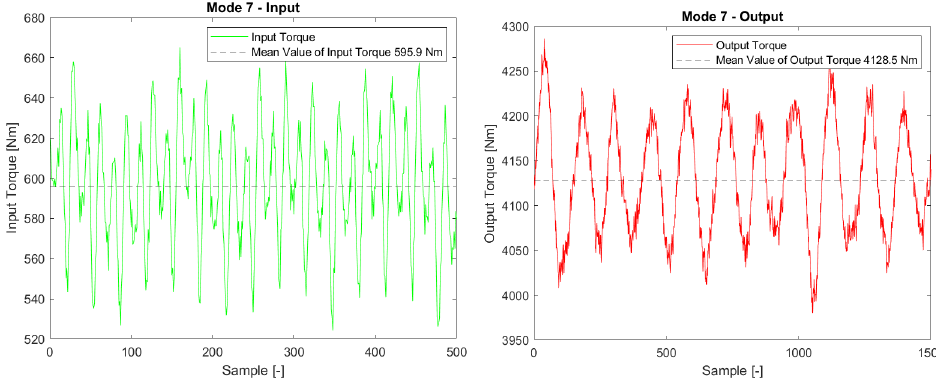
Figure 11. The recorded data—detail of Mode 7—input torque ( left ), output torque ( right